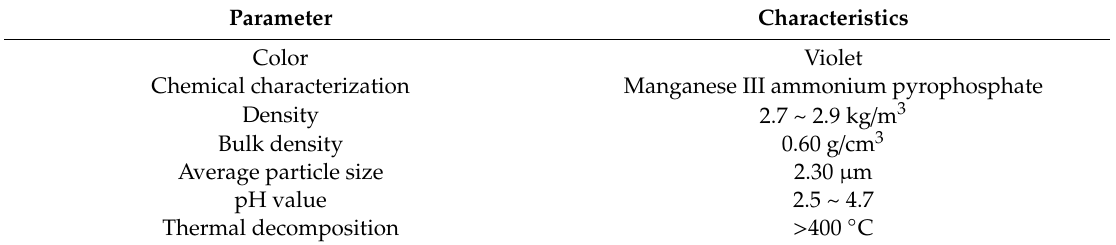
Table 1. Typical characteristics of MV